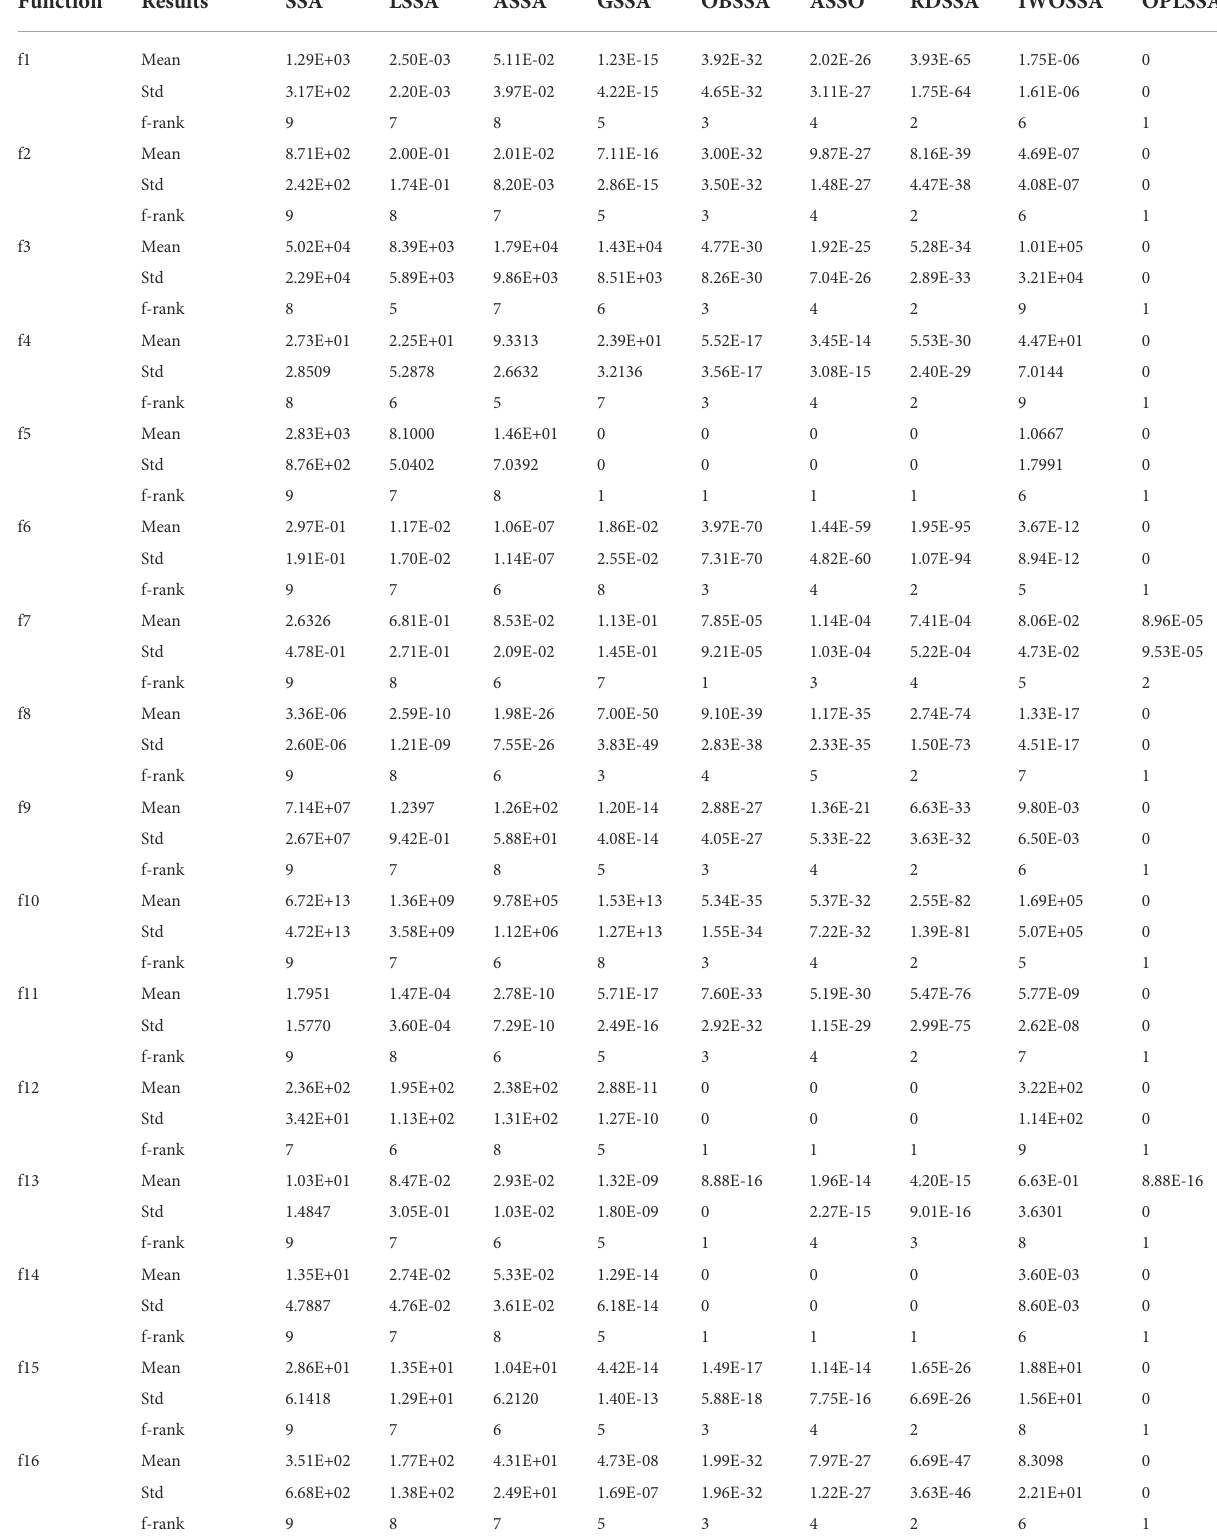
TABLE 3 Comparisons of nine algorithms on 23 test functions with 100 dimensions.